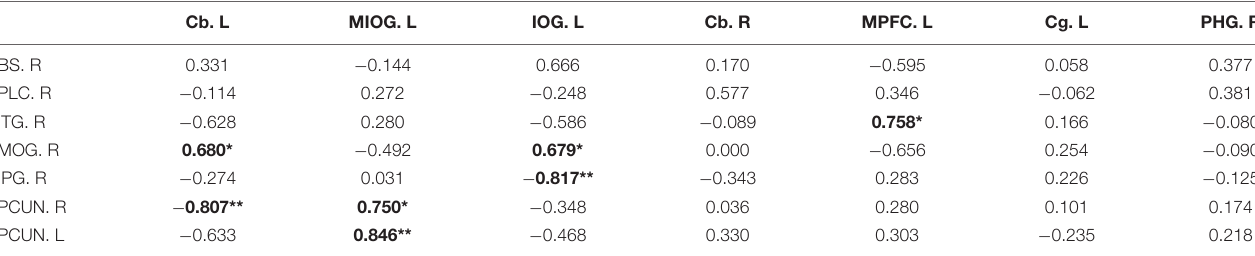
TABLE 5 | Pearson correlation between cerebral ReHo changings and cerebral ALFF changings in TOF group. Cb. L MIOG. L IOG. L Cb. R MPFC. L Cg. L PHG.